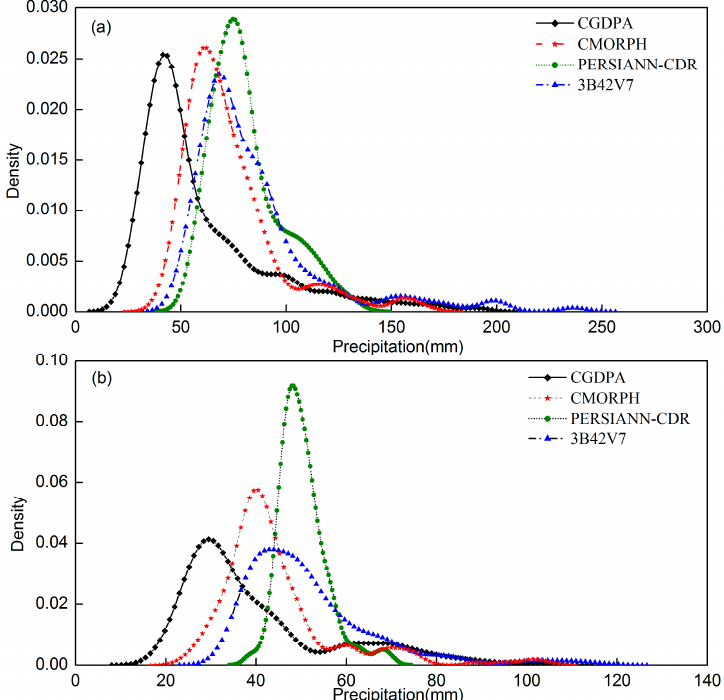
Figure 6. Probability density function (PDF) of ( a ) the highest and ( b ) the mean values of 16-year annual maximum daily precipitation in the Dadu River basin.